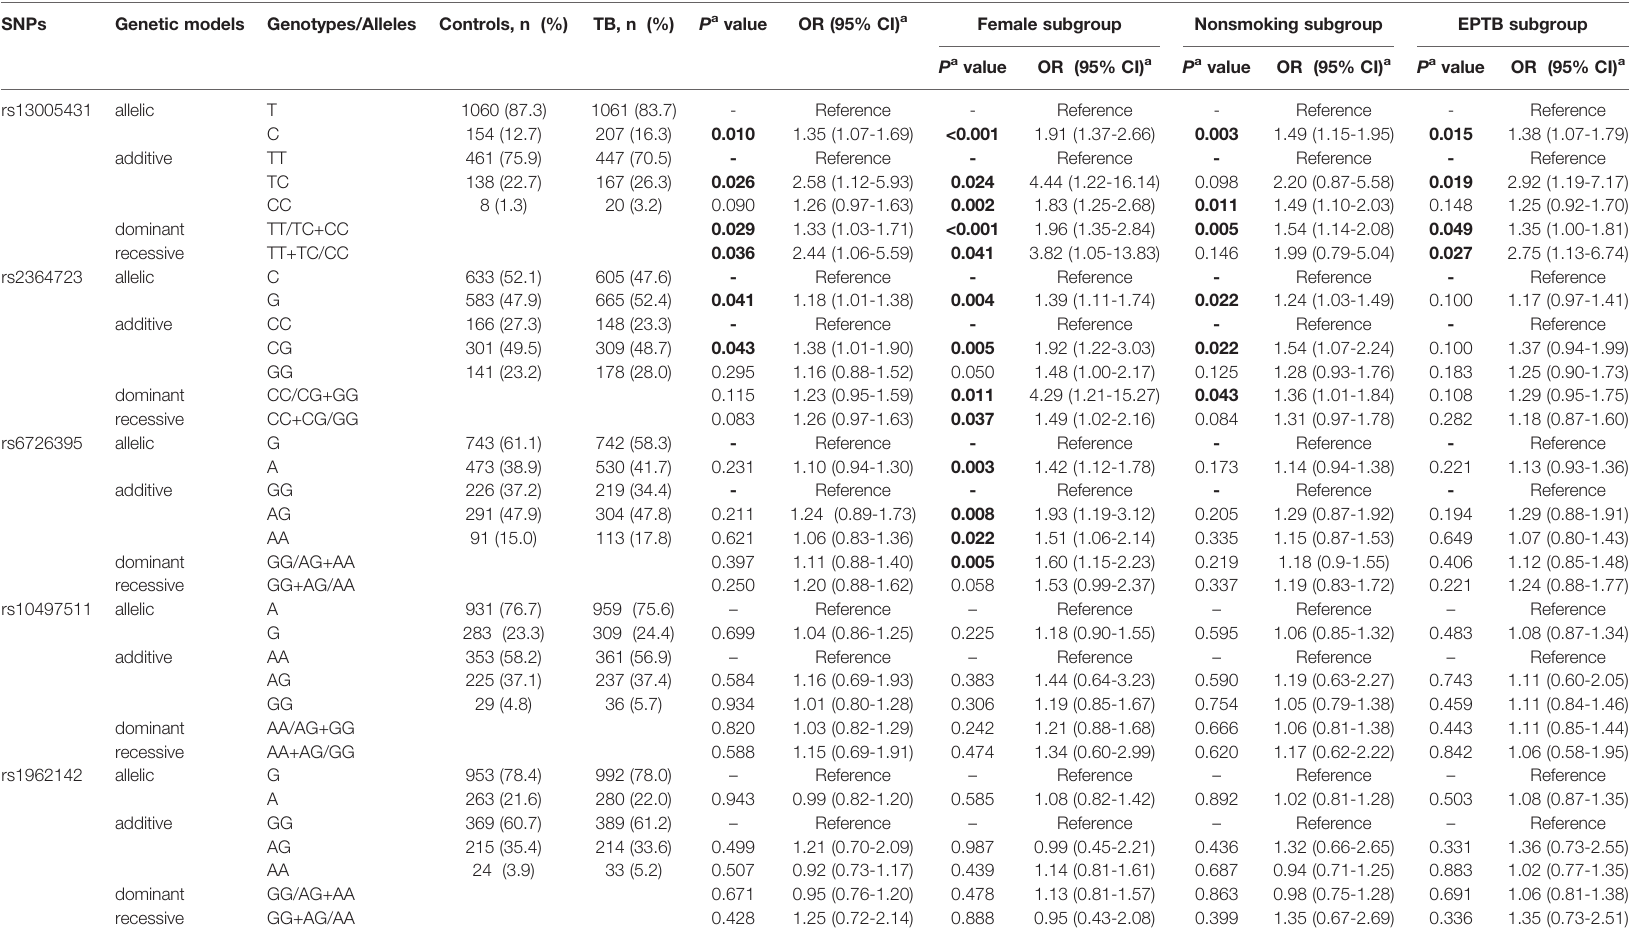
TABLE 2 | Signi fi cant associations between fi ve tagSNPs (rs13005431, rs2364723, rs6726395, rs10497511 and rs1962142) and tuberculosis risk in the discovery study and associations strati fi ed by gender, smoking status and TB types. SNPs Genetic models Genotypes/Alleles Controls, n